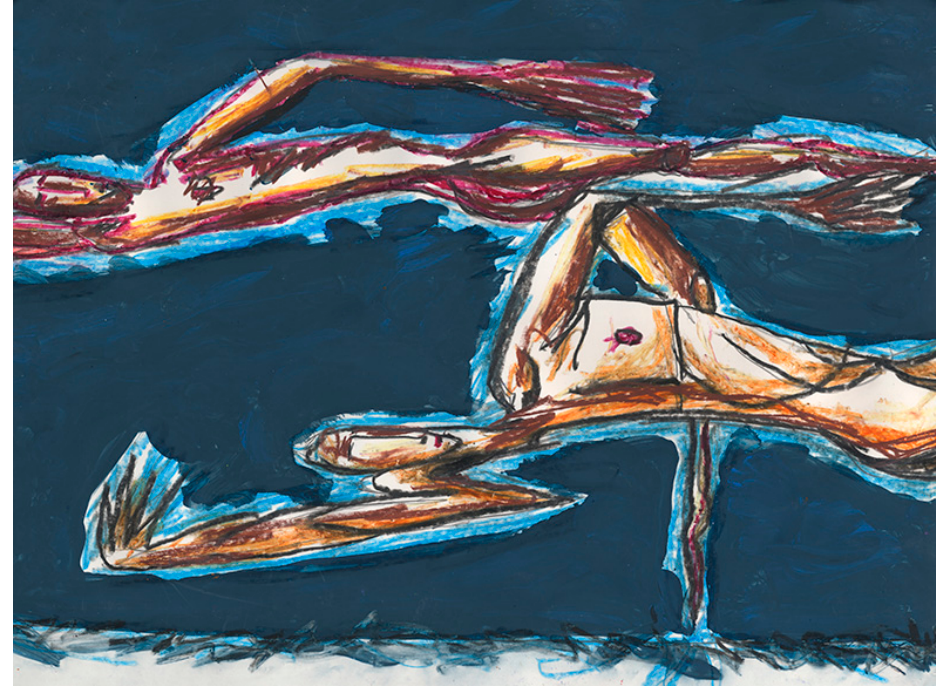
Figure 7. Ferdinando (aged 32, narcissistic personality disorder and opiate abuse), The Elegance of